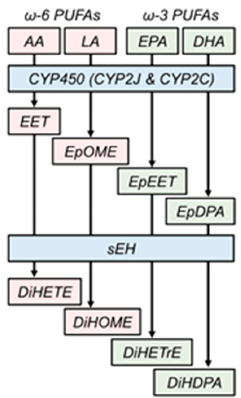
Figure 1. Endogenous role of soluble epoxide hydrolase. Cytochrome P450 monooxygenases catalyze the addition of an epoxide ring to polyunsaturated fatty acids, including omega-6 arachidonic and linoleic acids (AA and LA, respectively) and omega-3 eicosapentaenoic and docosahexaenoic acids (EPA and DHA, respectively) to form epoxy-fatty acids (epFAs). Soluble epoxide hydrolase (sEH) dihydroxylated fatty acids. EET, epoxyeicosatrienoic acid; EpOME, epoxyoctadecenoic acid; EpEET, epoxyeicosatetraenoic acid; EpDPA, epoxydocosapentaenoic acid; DiHETE, dihydroxyeicosatrienoic acid; DiHOME, dihydroxyoctadecenoic acid; DiHETrE, dihydroxyeicosatetraenoic acid; DiHDPA, dihydoxydocosapentaenoic